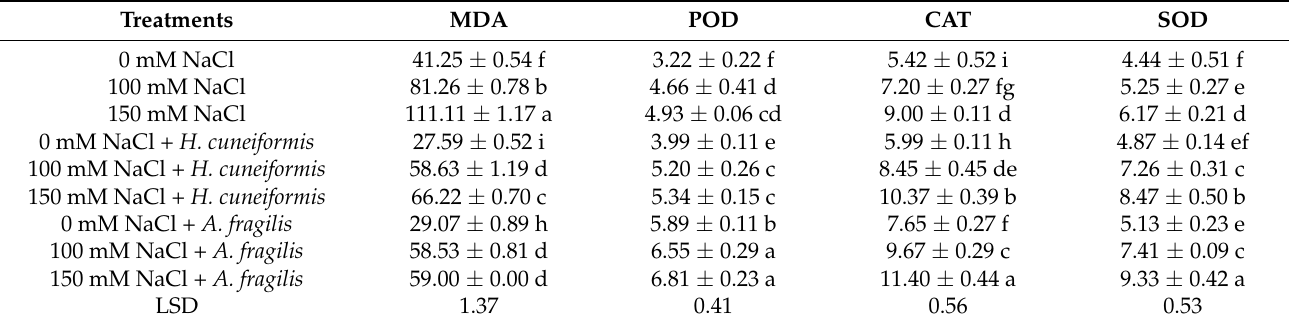
The effect of salinity stress on malondialdehyde (nmole MDA g − 1 FW), peroxidase activity ( µ